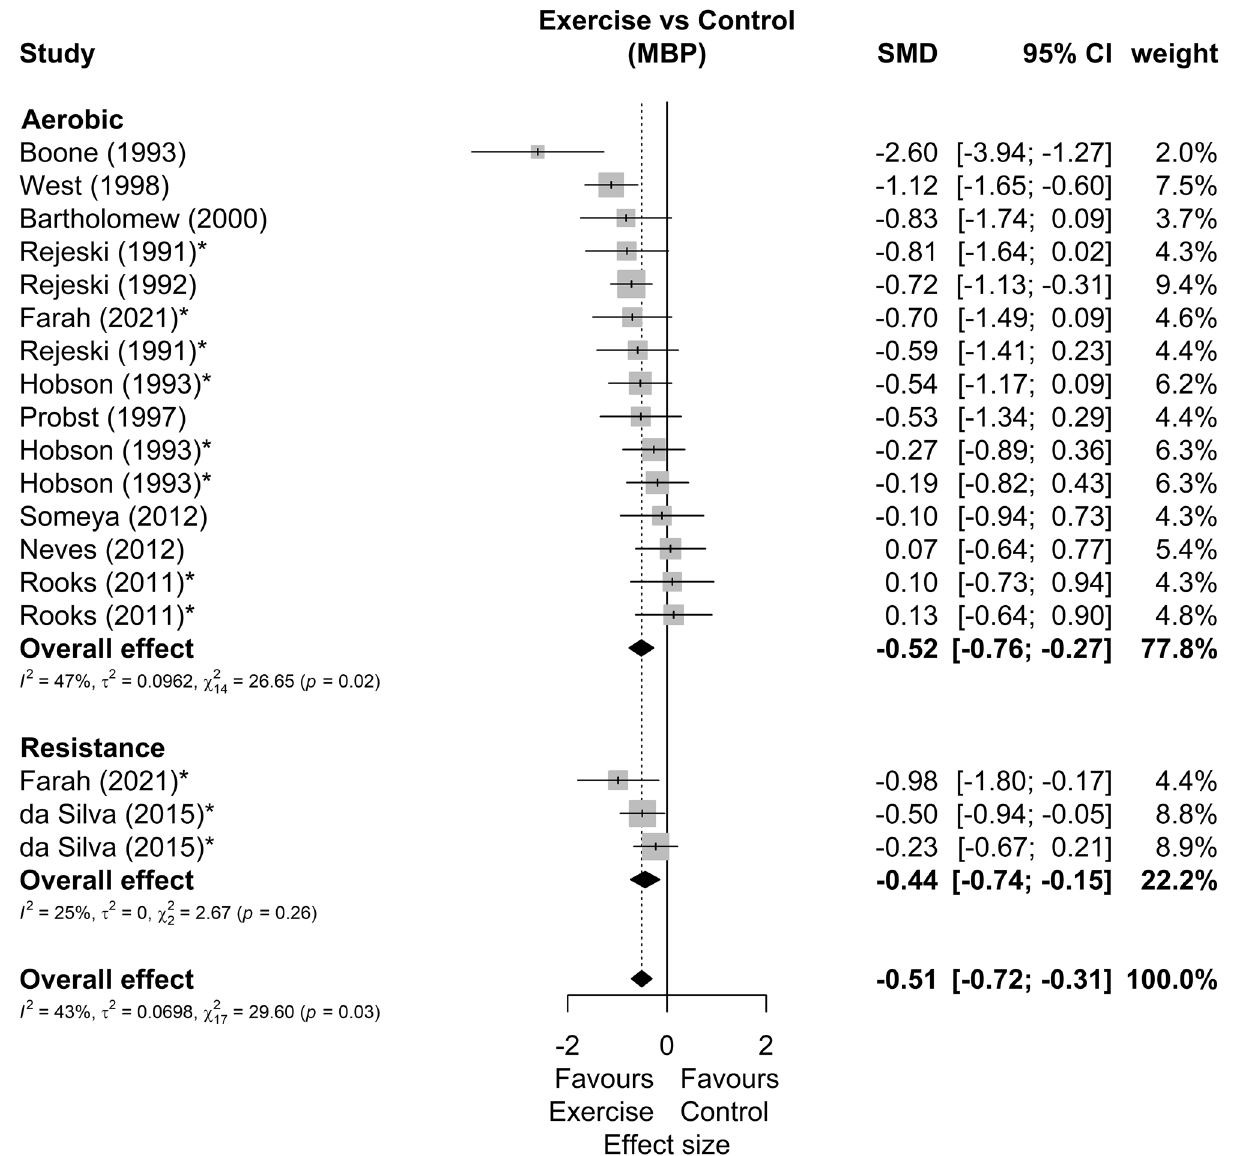
Figure 4. Mean blood pressure reactivity forest plot. SMD, standardized mean difference; MBP, mean blood pressure; CI, confidence interval; *, studies with multiple